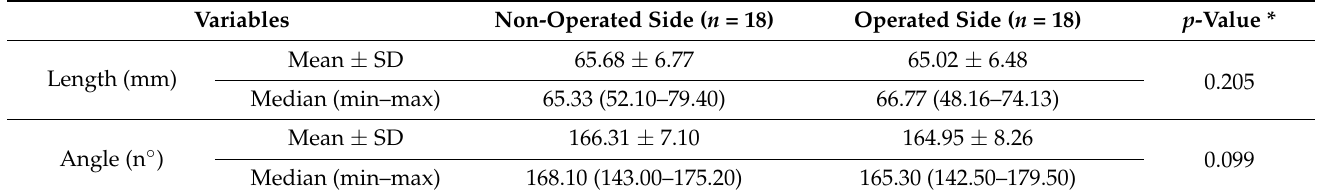
Table 2. Comparison between the operated and non-operated